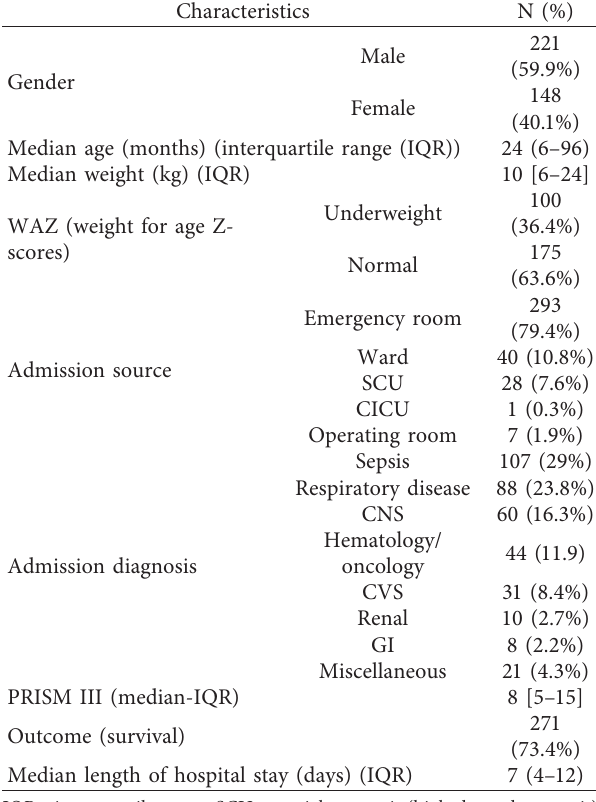
Table 1: Clinical characteristics of study population ( n � 369).